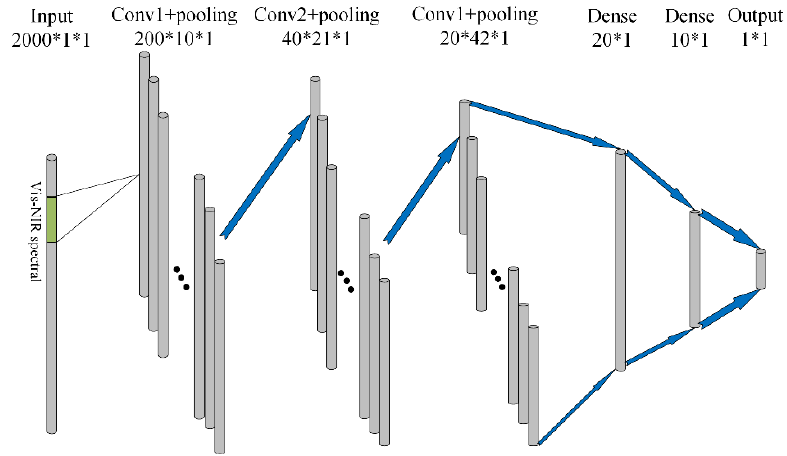
Figure 3. Structure of proposed CNN model for SS prediction.